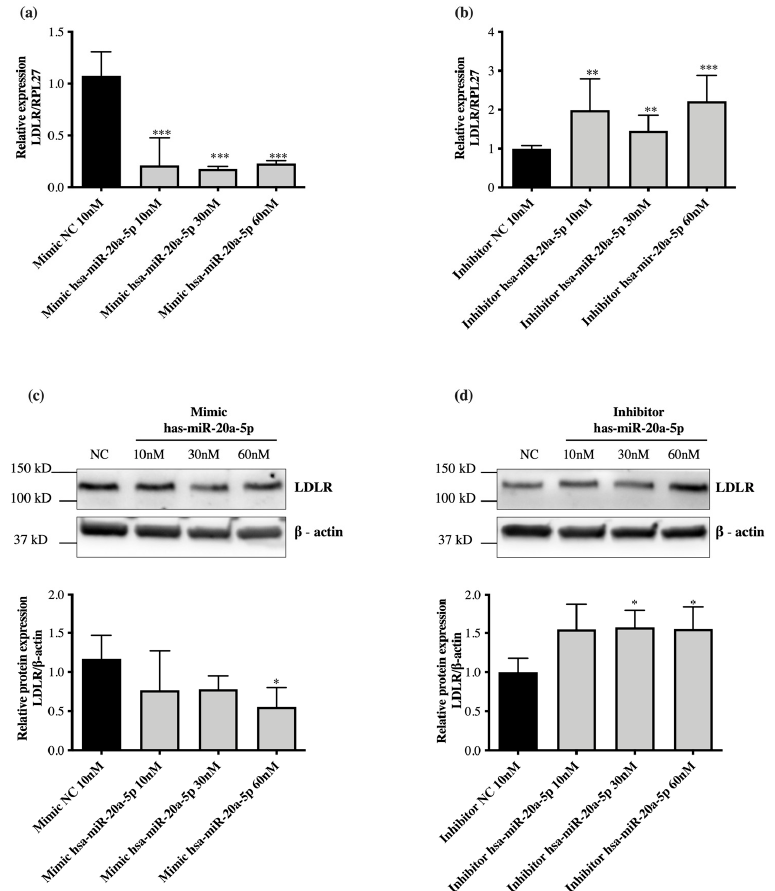
Figure 3. Binding sites for the miRNA hsa-miR-20a-5p in the 3 (cid:48) UTR region of LDLR . The 3 (cid:48) UTR region of LDLR in humans has two predicted and conserved binding sites for hsa-miR-20a-5p. The seed sequence of hsa-miR-20a-5p is shown in red, while its respective complementary region in the 3 (cid:48) UTR is shown in blue. Conserved sites between species are shown below: hsa, human; ptr, chimpanzee; mmu, mouse; rno, rat. LDLR: low-density lipoprotein receptor; UTR: untranslated region.